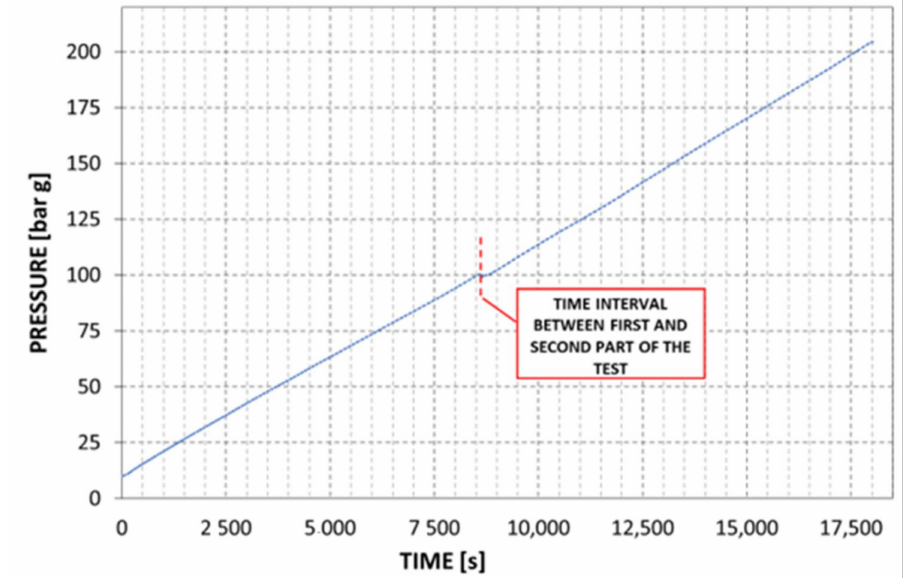
Figure 9. Plot over time of the hydrogen pressure on the hydrogen storage during the test with hydrogen compressor running at 44 cycles per